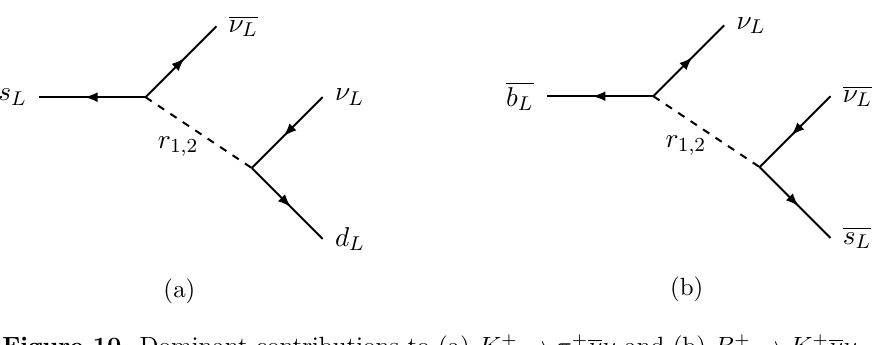
Figure 10 . Dominant contributions to (a) K + ! (cid:25) + (cid:23)(cid:23) and (b) B + ! K + (cid:23)(cid:23) . Process Parameters Constrained Constraints (GeV) (cid:0) 2